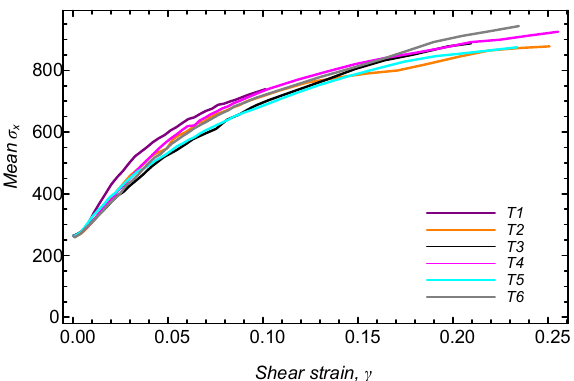
Figure 10. Mean σ x throughout the tests, taken as 0.5 ( f ( θ = 0 ) + f ( θ = π )) .